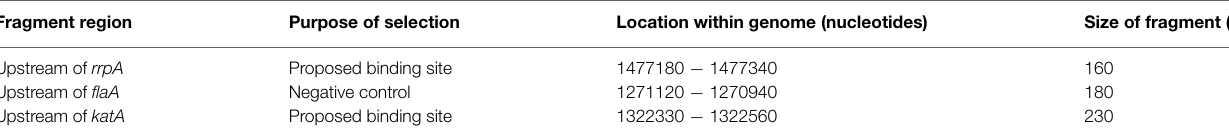
TABLE 3 | DNA fragments used as promoter probes for electrophoretic mobility shift